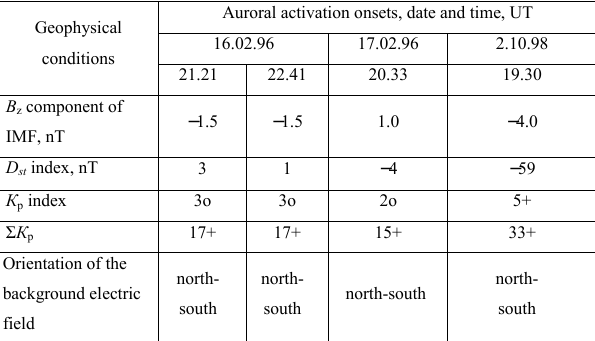
Table 3. Background geophysical conditions in the course of the HF pumping